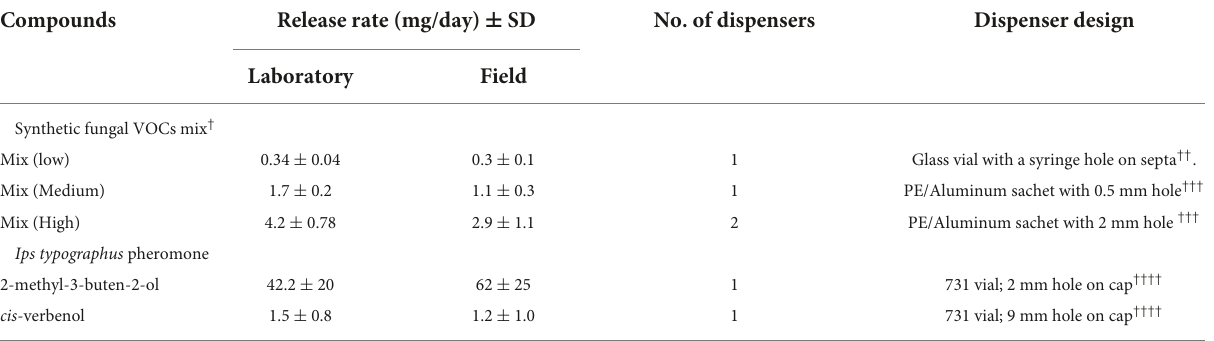
TABLE 1 Design and release rates of artificial dispensers containing the mixture of fusel alcohols and acetates. Compounds